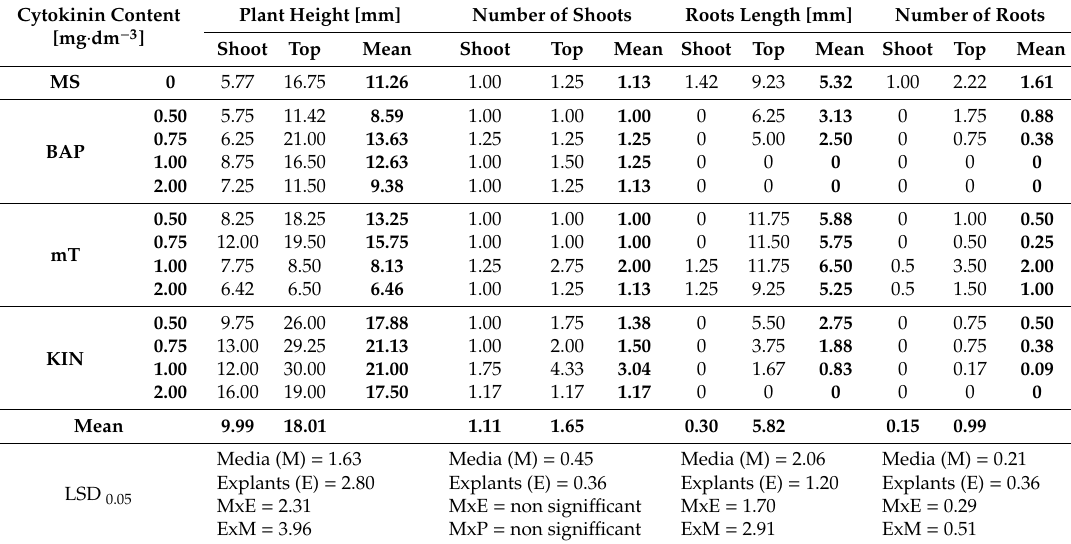
Table 1. E ff ects of type explants and cytokinin content on the shoot multiplication of Honckenya